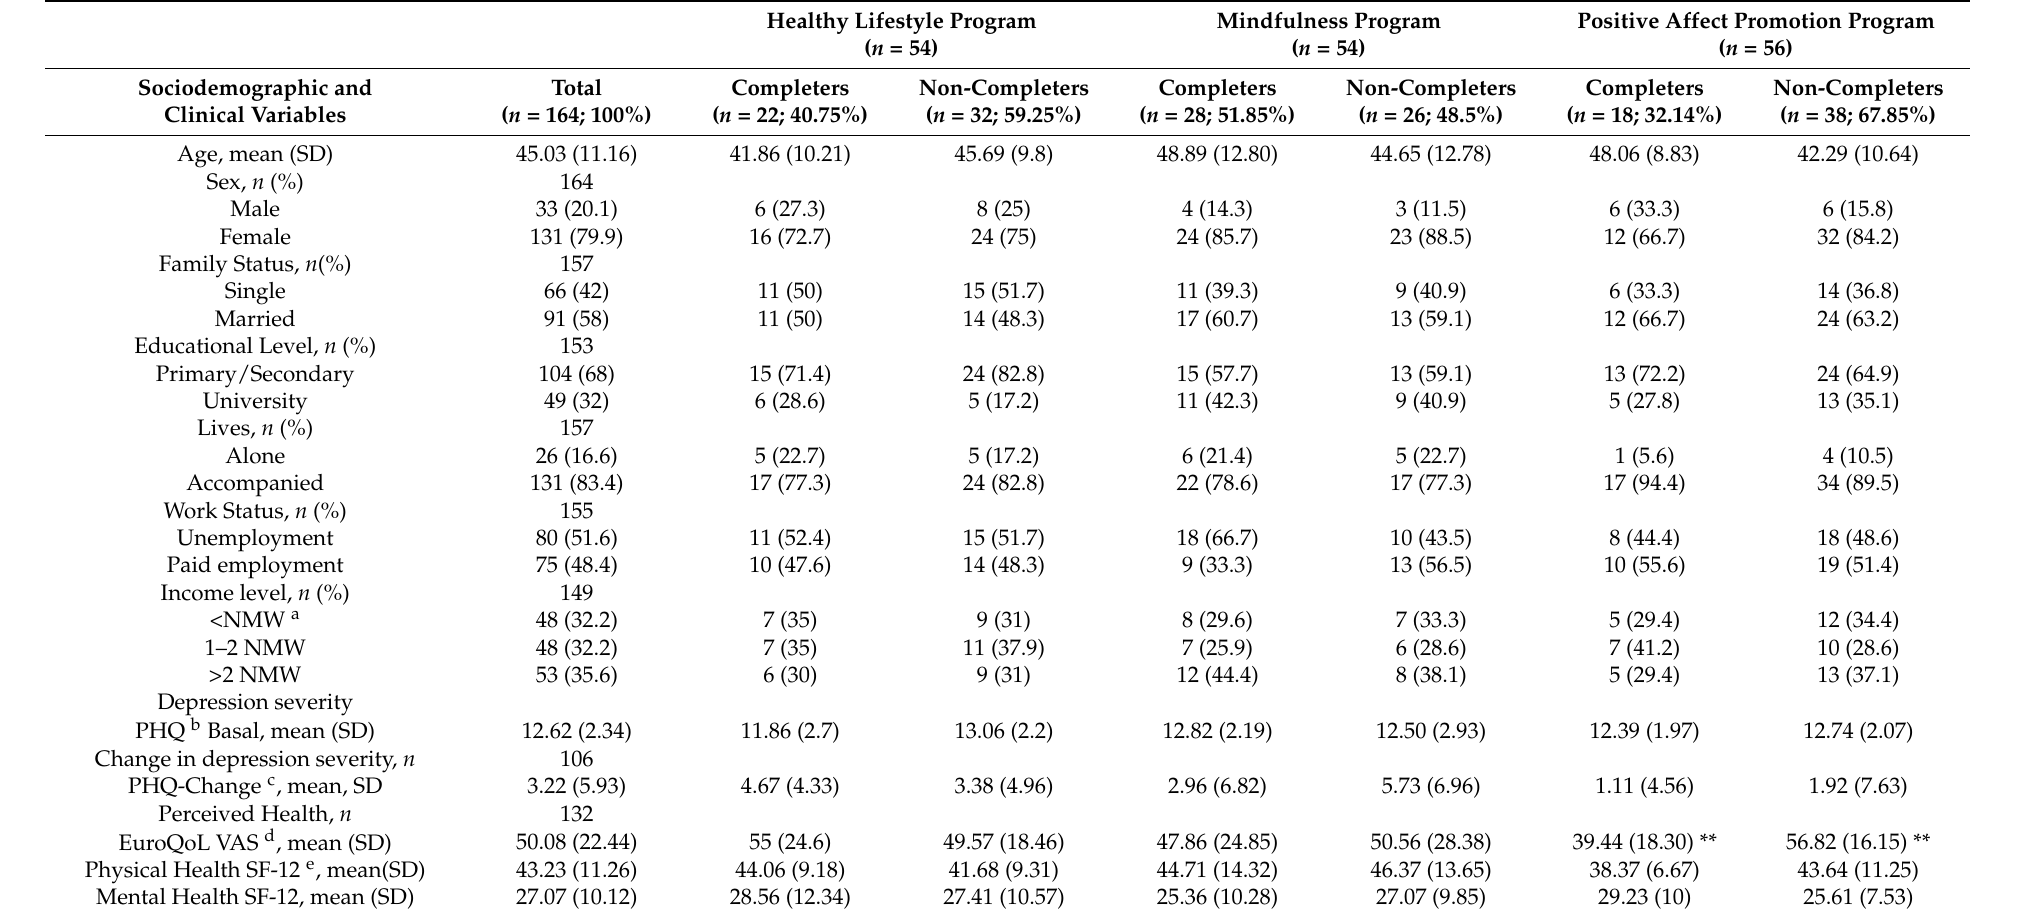
Table 1. Baseline sociographic and clinical characteristics and comparisons between treatment completers and